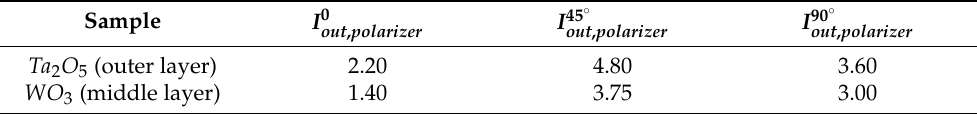
Figure 6. Output light intensities of the reference and sensing arms with double-layer deposited films of ( a ) Ta 2 O 5 ( outer layer ) and ( b ) WO 3 ( middle layer ) placed in the proposed system. Table 2. Output intensities with BK-7 and double-layers thin-films placed in the proposed system.